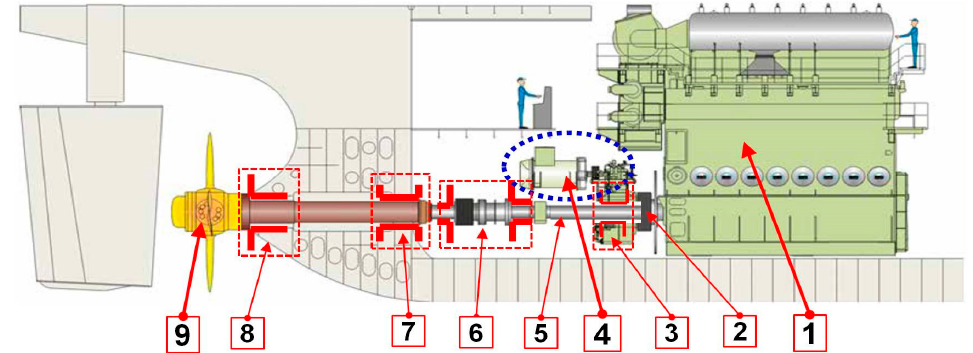
Figure 3. Example of ship’s main propulsion with shaft generator and PTO/PTI system: 1—marine low-speed, two-stroke diesel engine—main engine (ME); 2—hydraulic separable coupling; 3—shaft generator gear; 4—shaft generator (PTO/PTI); 5—intermediate shaft; 6—thrust bearing of intermediate shaft; 7—bearing of screw shaft; 8—stern tube; 9—fixed pitch propeller (own elaboration using MAN drawing [30]).